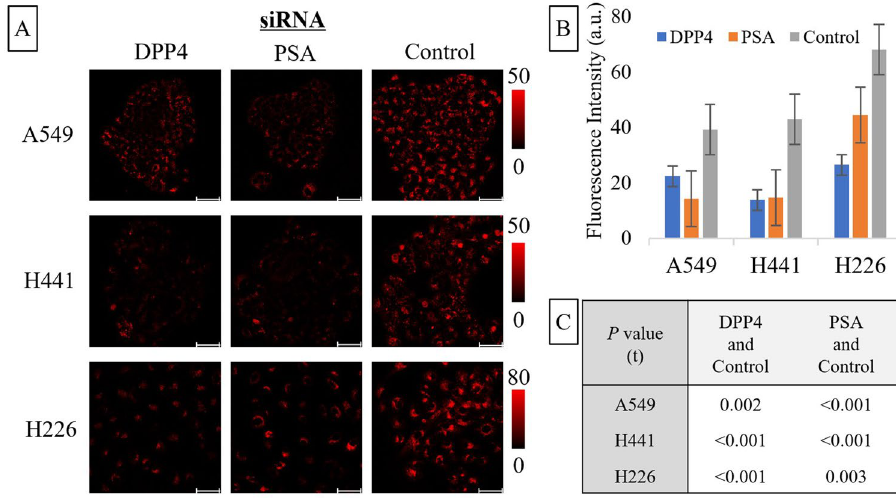
Figure 6. (A) Images taken 10 min after addition of QA-2OMeSiR to cell lines at 2 days after siRNA transfection. A549, H441, and H226 cells transfected with DPP4 siRNA or PSA siRNA show a suppressed increase of fluorescence compared to the Control siRNA-transfected cell lines. The scale bar represents 50 µm. ( B) Increase in fluorescence intensity at 10 min after addition of QA-2OMeSiR, averaged over 15 cells. ( C) Mean values of 15 measurements for each cell line and results of statistical comparison (t-test) of the effects of the siRNAs used.